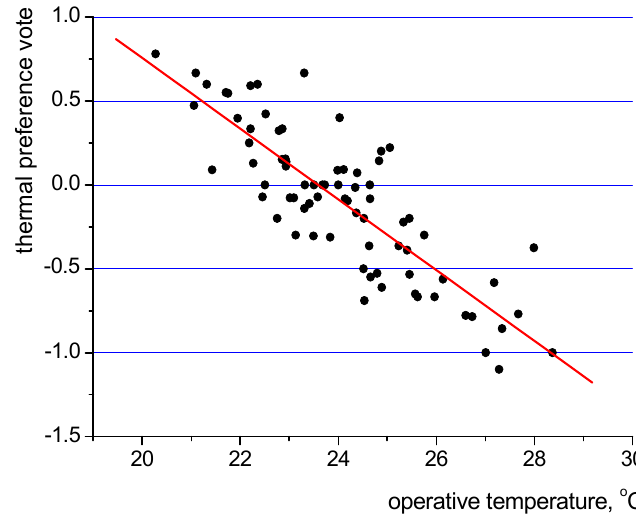
Figure 13. Relationship between average thermal preference and operative temperature based on 1369 questionnaires.